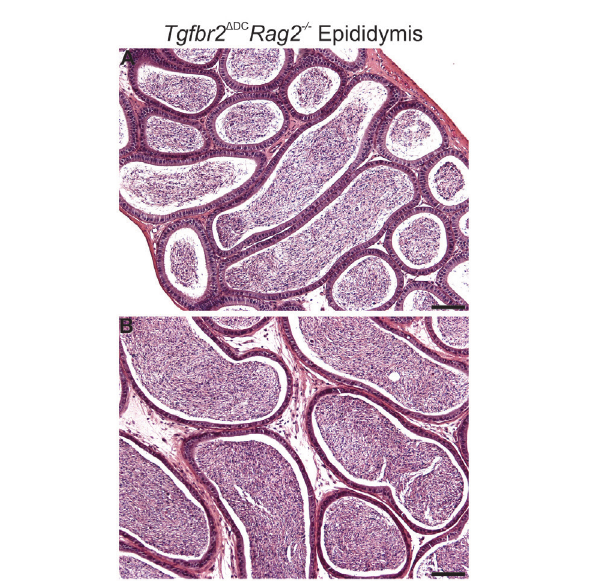
FigUre 2 | Males lacking both mature lymphocytes and transforming growth factor beta (TGF β )-signaling in dendritic cells (DCs) do not develop epididymal leukocytosis. Typical images from corpus (a) and cauda (B) epididymis from Tgfbr2 Δ DC Rag2 − / − males. Abundant sperm are in luminal spaces; however, no